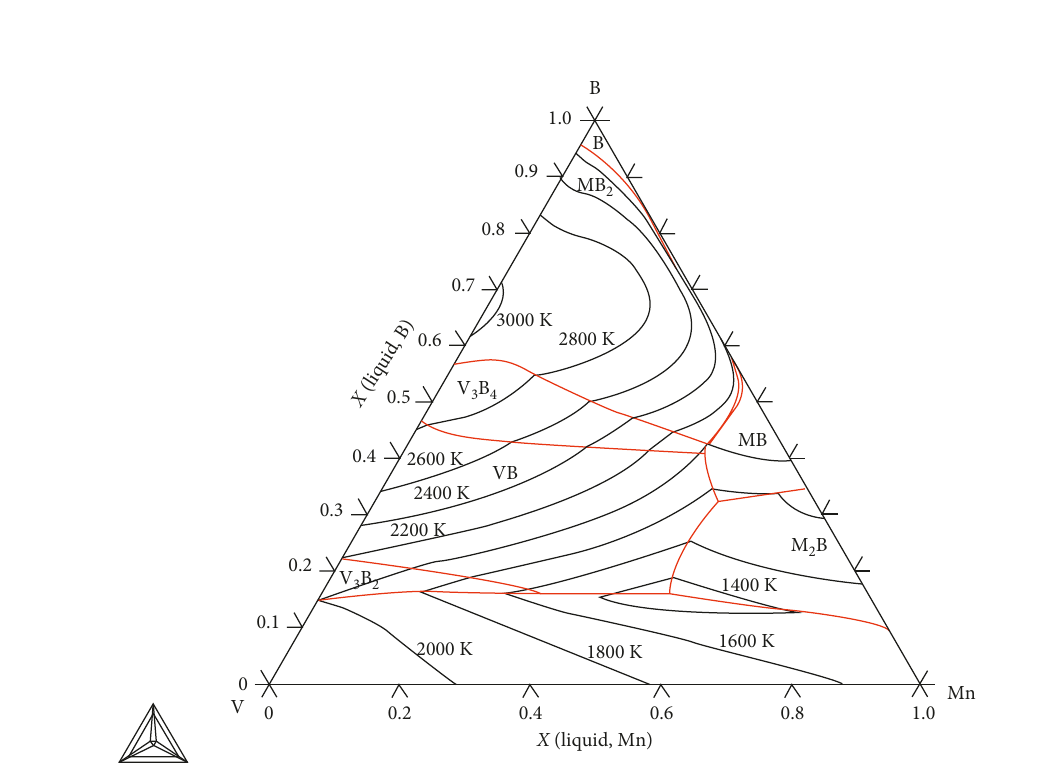
Figure 3: Liquidus projection of the B-Mn-V system.